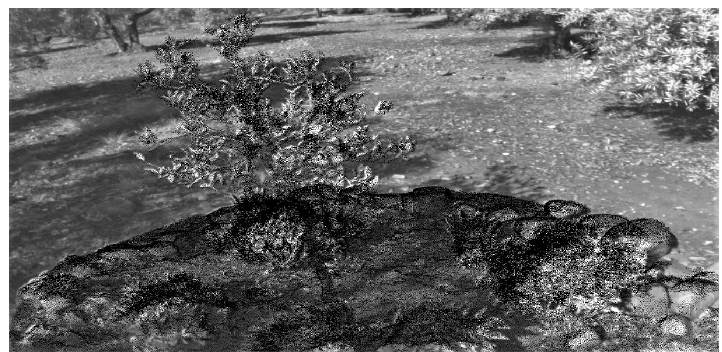
Figure 7. Image-based validation of inverse 3D